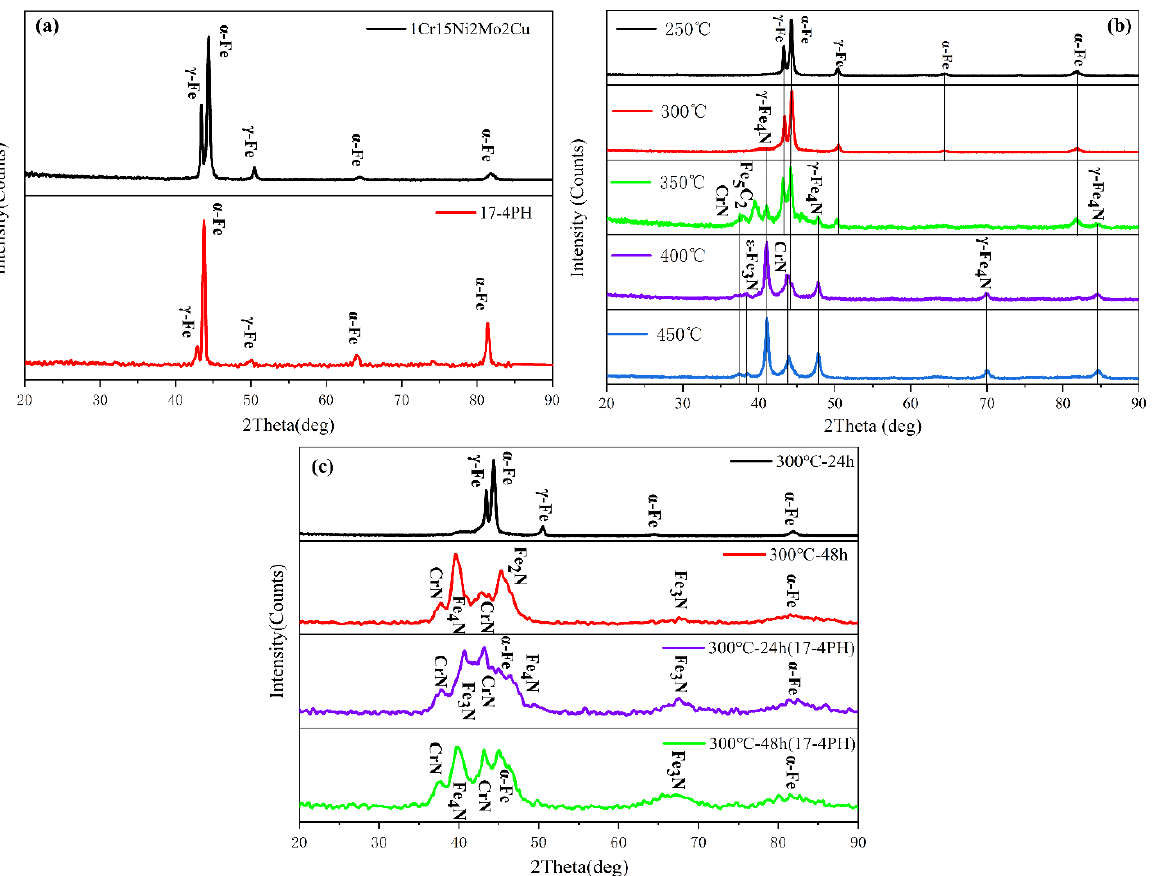
Figure 7. XRD curves of stainless steel by nitriding treatment of different conditions: ( a ) BM; ( b ) 1Cr15 nitriding for 24 h at different temperatures; ( c ) 17-4PH and 1Cr15 nitriding at 300 °C for different times. Table 5. EDS data of nitrided layer surface (wt.%). Sign N Cr Fe Mo Precipitate area (green rectangle) Smooth area (red